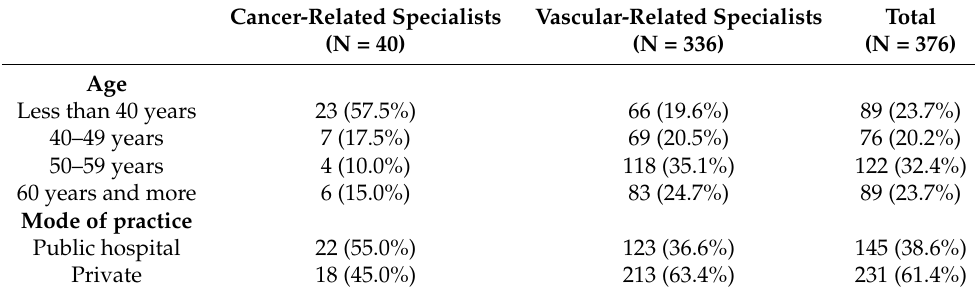
Table 1. Participants’ characteristics according to the medical speciality.